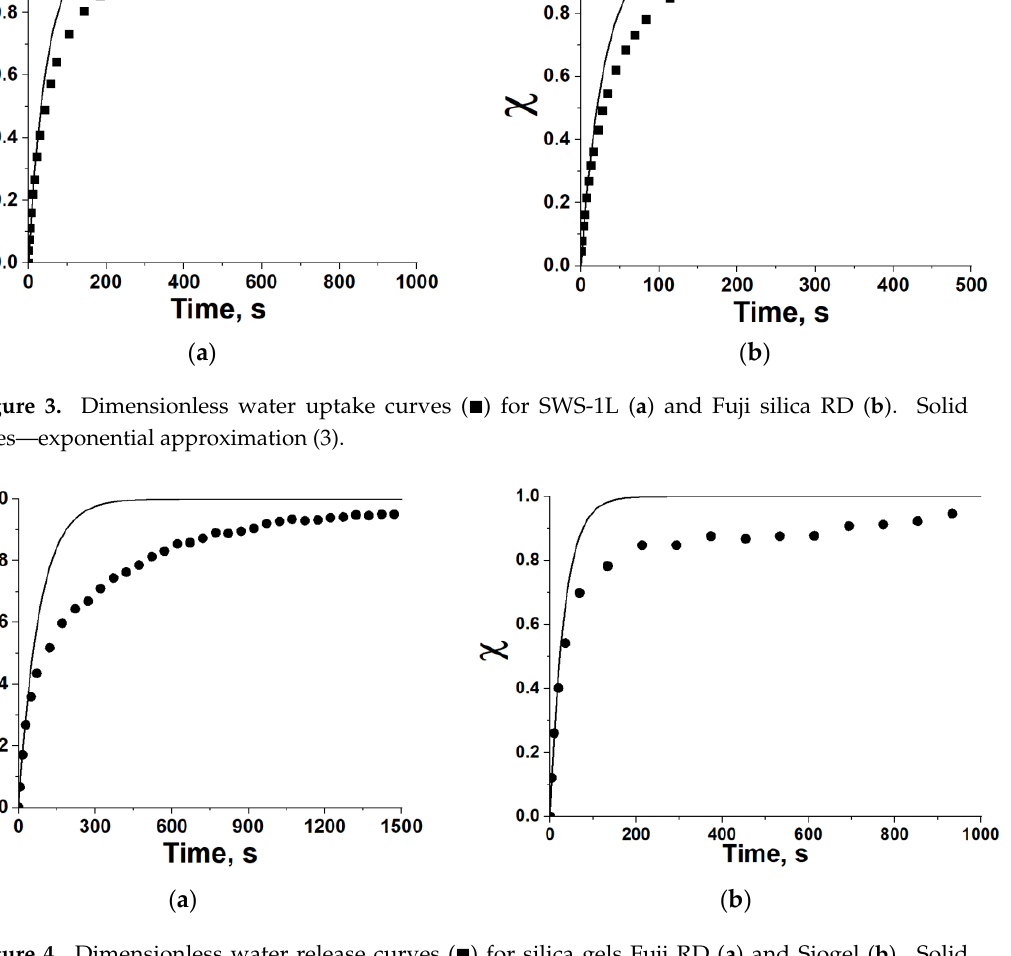
lines—exponential approximation (3). Figure 4. Dimensionless water release curves ( ■ ) for silica gels Fuji RD ( a ) and Siogel ( b ). Solid lines —